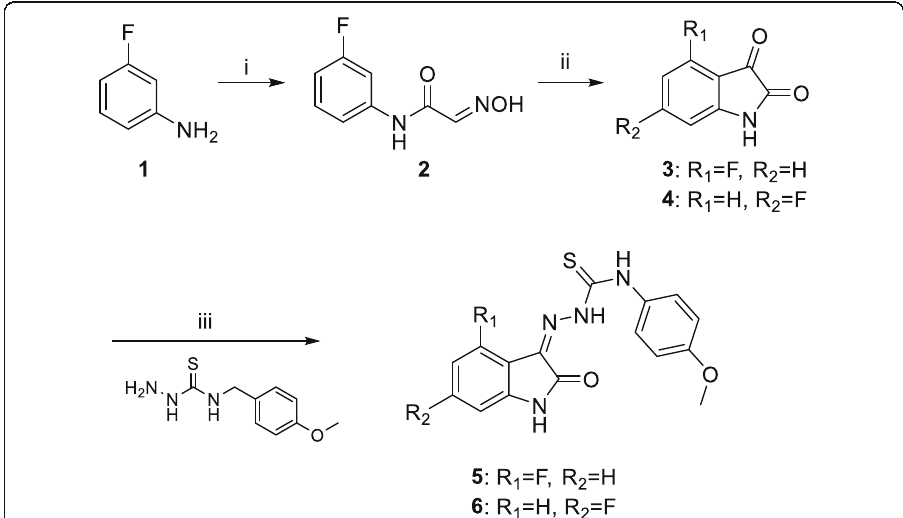
Fig. 1 Reaction conditions: i: Na 2 SO 4, chloral hydrate , H 2 O, HCl, hydroxylamine hydrochloride 90 °C 2 h; ii H 2 SO 4 85 °C 15 min; iii ethanol 110 °C 2